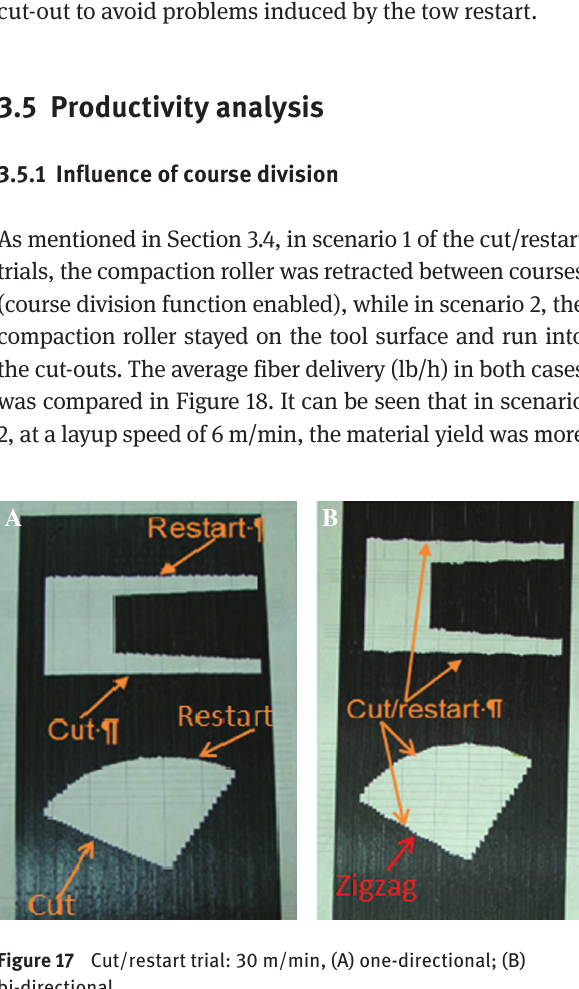
Figure 17 Cut/restart trial: 30 m/min, (A) one-directional; (B)